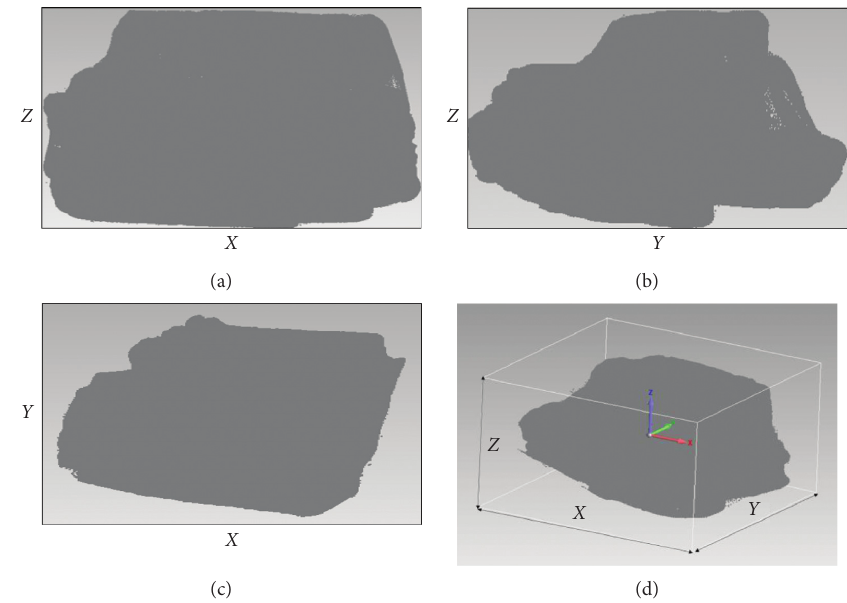
Figure 6: 3D view of irregular karst caves. (a) Front view. (b) Side view. (c) Top view. (d) Stereo